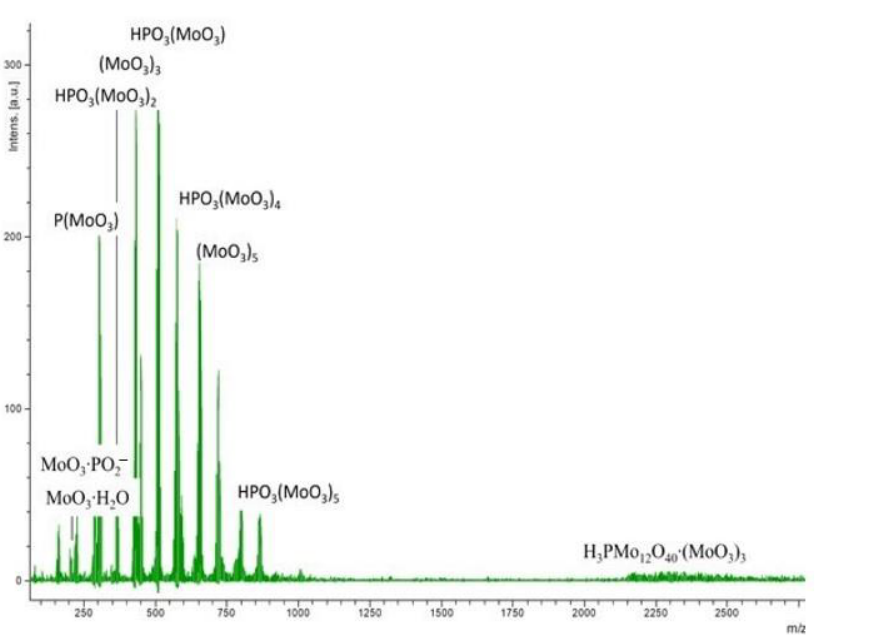
Figure 6. SALDI mass spectra of the PMo2 catalyst in the negative ion detection